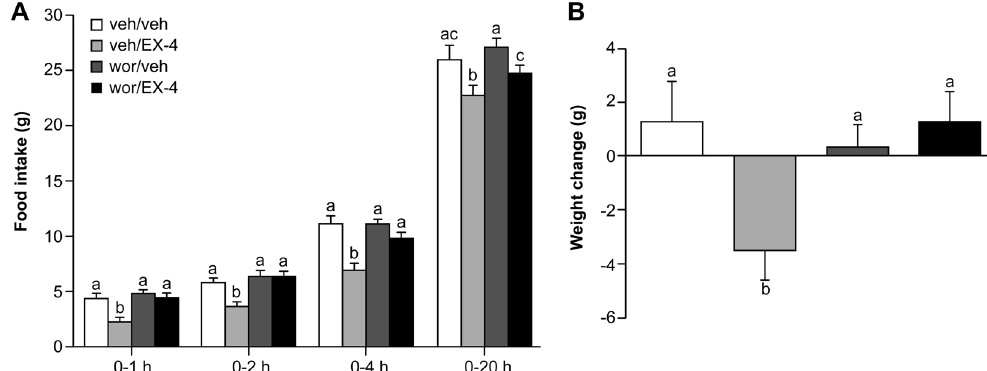
Figure 2. Food intake at 1, 2, 4, and 20 h ( A ) and 24 h body weight change ( B ) after ICV administration of wortmannin or vehicle and intrapretoneal injection of EX-4 or vehicle. A, Food intake was significantly